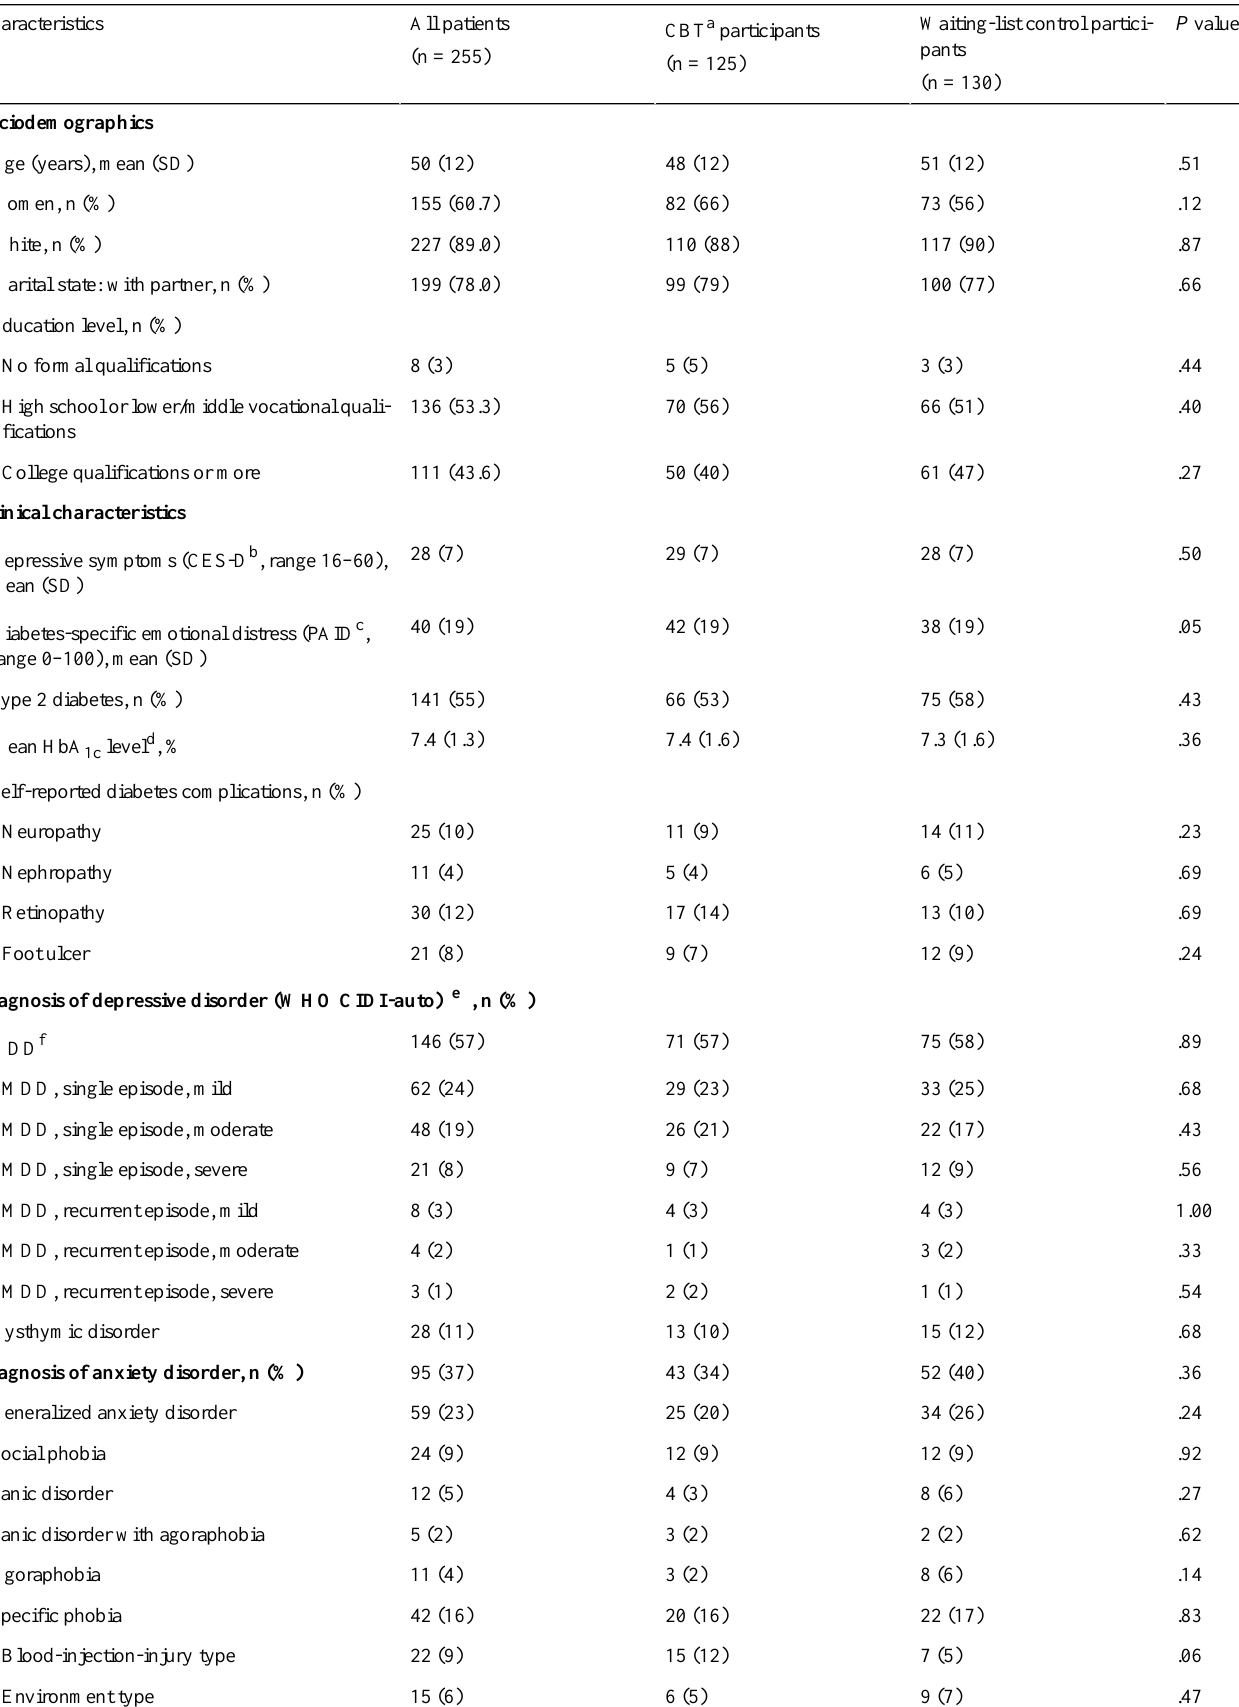
Table 1. Baseline sociodemographic and clinical characteristics of study sample at baseline